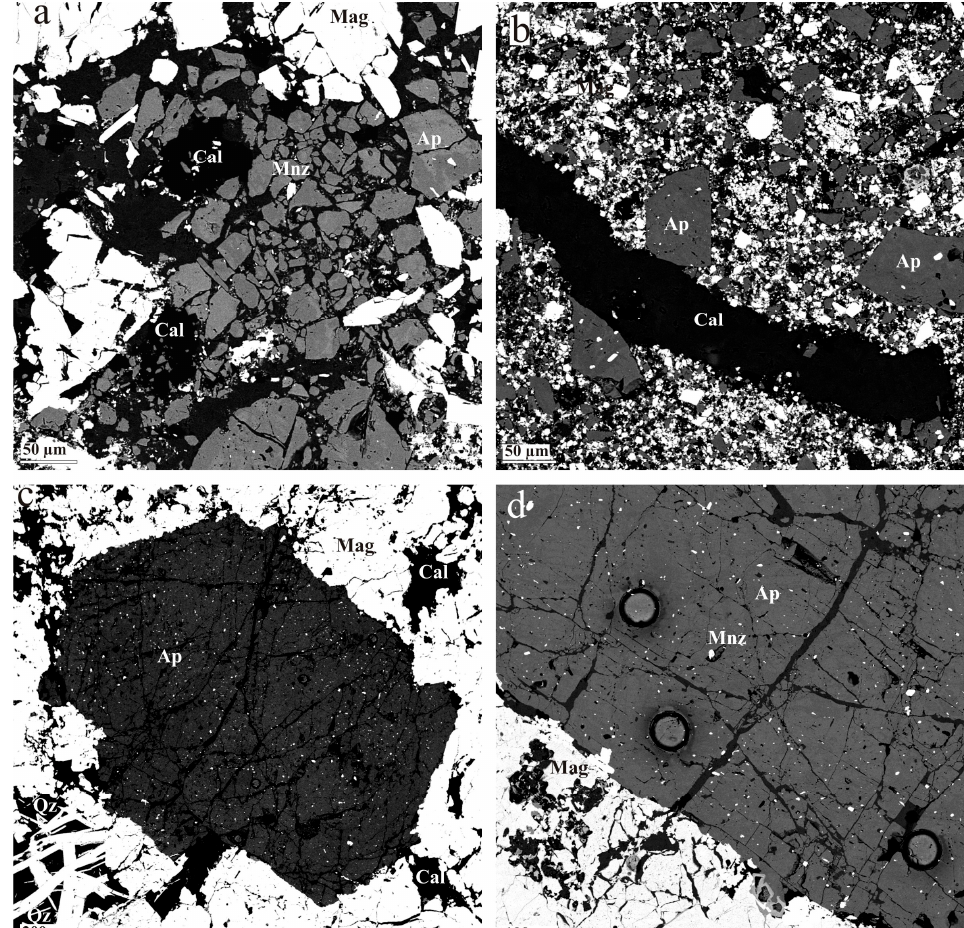
Figure 6. SEM-BSE images of apatite from MAA-marginal type in the Chadormalu iron ores. ( a,b ) Brecciated apatite (gray) and magnetite (white) crystals. In details, the apatites show dark and bright zones with fine monazite inclusions; ( c ) Euhedral apatite crystals (medium gray) with monazite grains (bright spots) enclosed in magnetite-hematite (light grey); ( d ) Apatite (grey) with fine monazite inclusions (bright spots within Ap) mostly near or on the fractures, enclosed in magnetite (light grey, lower left). Abbreviations: Ap = apatite; Mag = magnetite; Mnz = monazite; Cal = calcite; Qz = quartz.